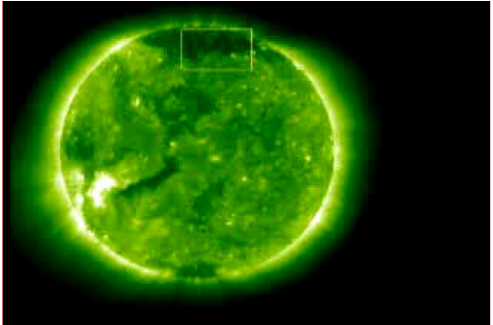
Figure 14: Still from a movie showing An animation built on SOHO/EIT and SOHO/SUMER observa- tions of the solar-wind source regions and magnetic structure of the chromospheric network. Outflow veloc- ities, at the network cell boundaries and lane junctions below the polar coronal hole, reach up to 10 km s –1 are represented by the blue colored areas (original figures from Hassler et al. , 1999). (To watch the